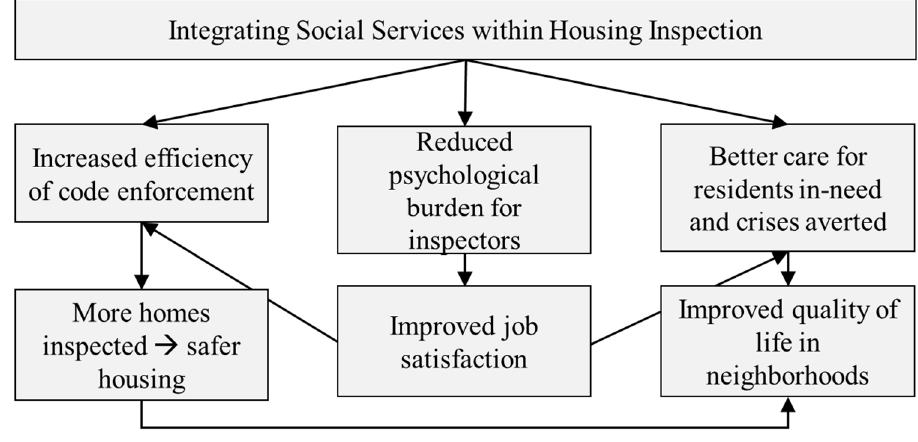
Figure 2. Theory of change for impact of the social service referral program.